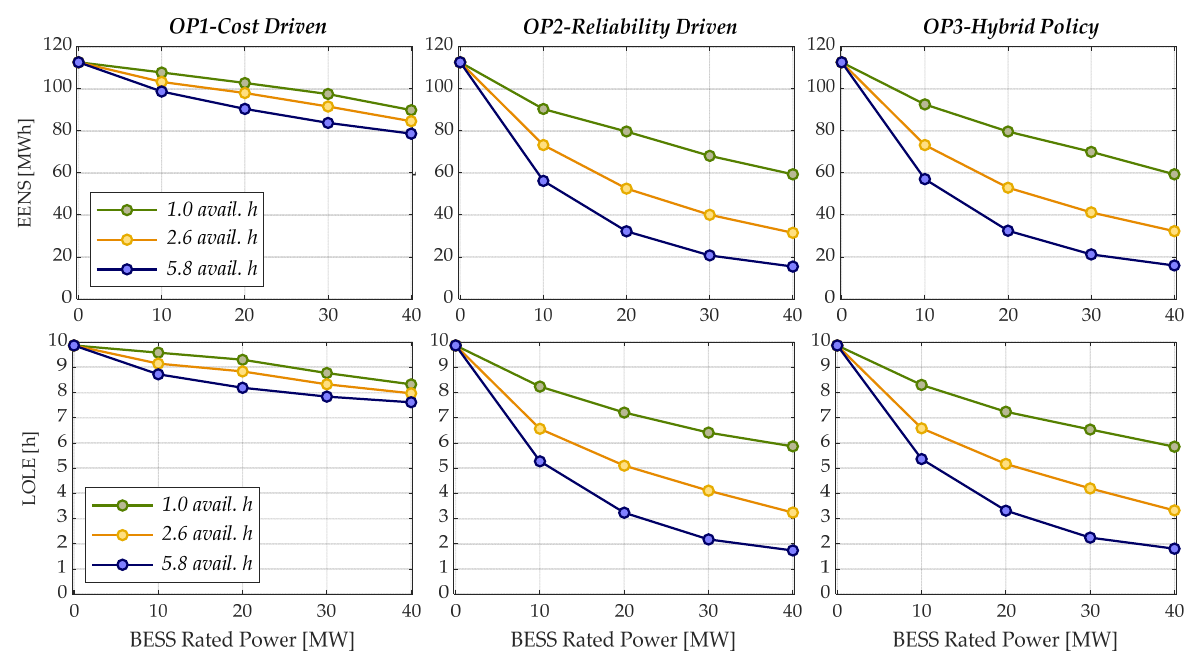
Figure 6. EENS and LOLE achieved by different BESS configurations for the alternative OPs.